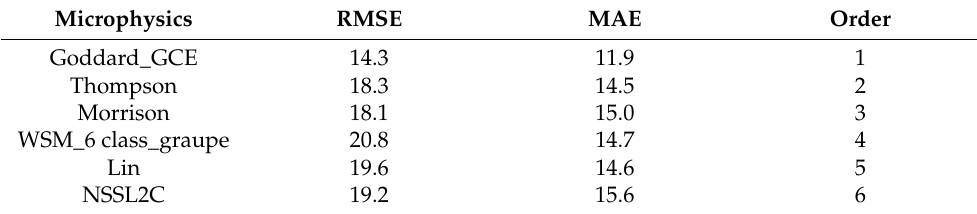
Table 6. Estimated errors for different microphysics schemes against 37 Egyptian rain observations. Microphysics RMSE MAE Order Goddard_GCE 14.3 11.9